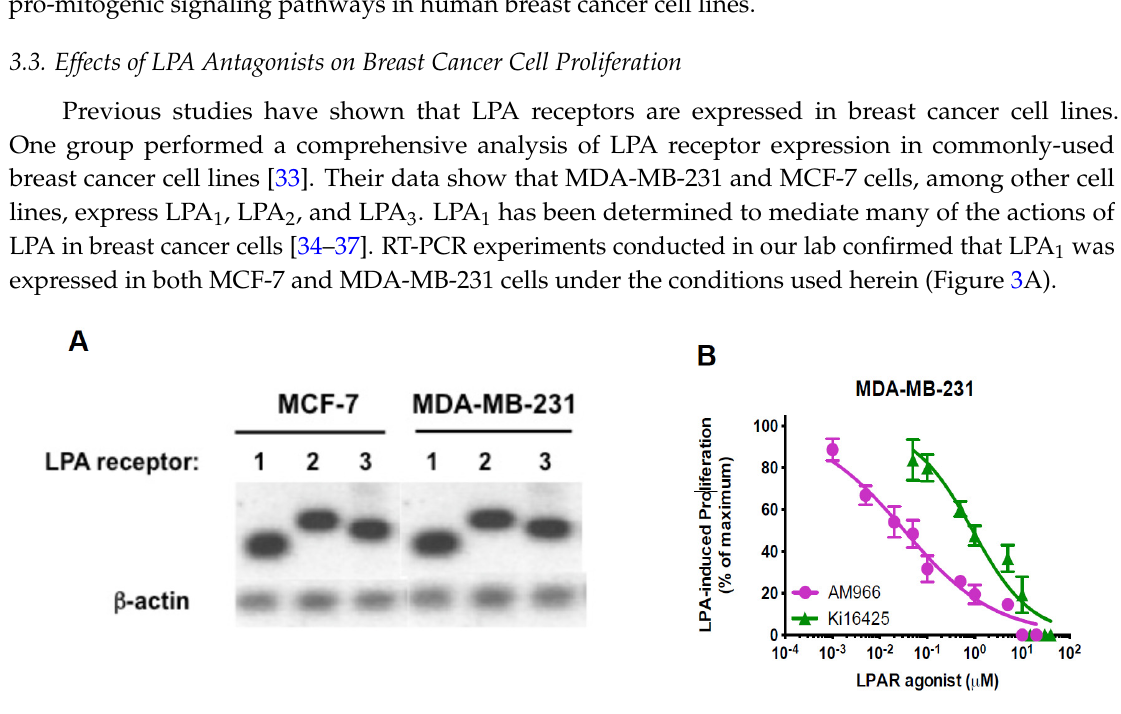
Figure 3. LPAR expression in breast cancer cell lines, and dose ‐ response for the effects of LPA 1 antagonists on MDA ‐ MB ‐ 231 cell proliferation. ( A ) Total RNA was extracted from MCF ‐ 7 and MDA ‐ MB ‐ 231 breast cancer cells. RT ‐ PCR was performed (separate gels for each cell line) using the cDNA primers described in the Methods. ‐ actin was amplified as loading control; ( B ) Serum ‐ starved MDA ‐ MB ‐ 231 cells were incubated for 48 h with and without 10 μ M LPA in the absence and presence of the indicated concentrations of Ki16425 or AM966. The number of cells achieved in response to LPA alone was defined as 100% response; the number of cells in the absence of LPA was defined as 0% response. Each point represents mean ± SEM ( n ≥ 4) for values obtained from at least two experiments, each performed with two separate replicate wells of cells for each condition.